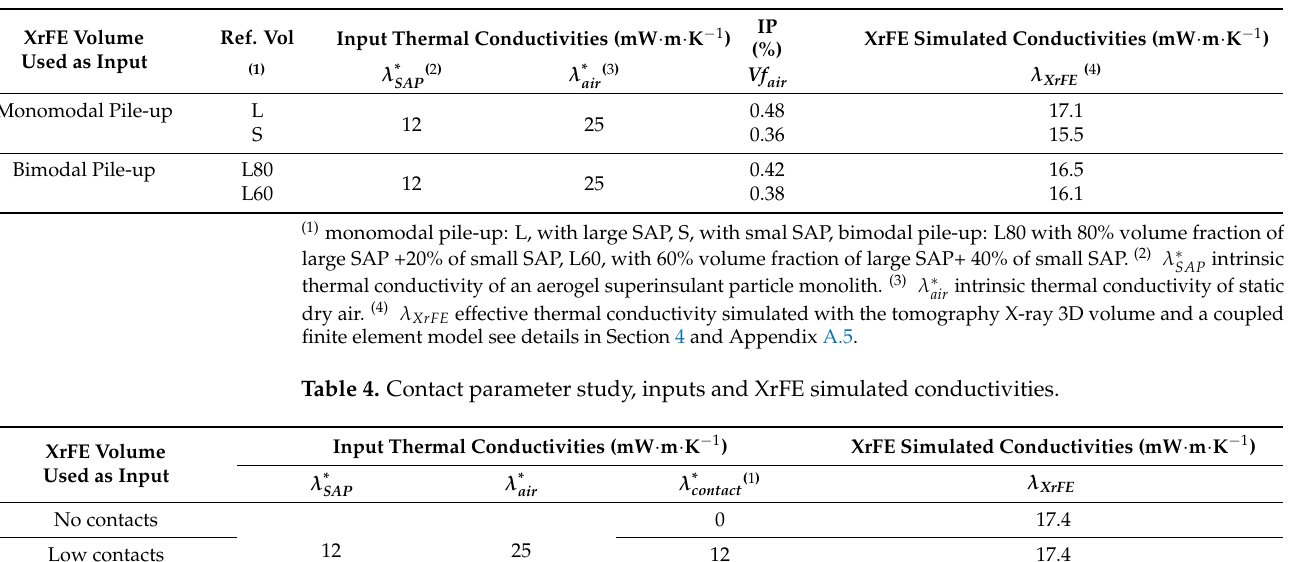
Figure 5. 3D reconstructed X-ray tomogram illustrating the post-treatments performed: ( a ) segmen- tation and medium filter applied, with view of SAP only; ( b ) watershed applied, contacts between grains only viewed. The dark 2D square in the image illustrates a possible cross-section. (reprinted with permission from [46]). Table 3. Pile-up compacity parameter study, inputs and XrFE simulated conductivities.